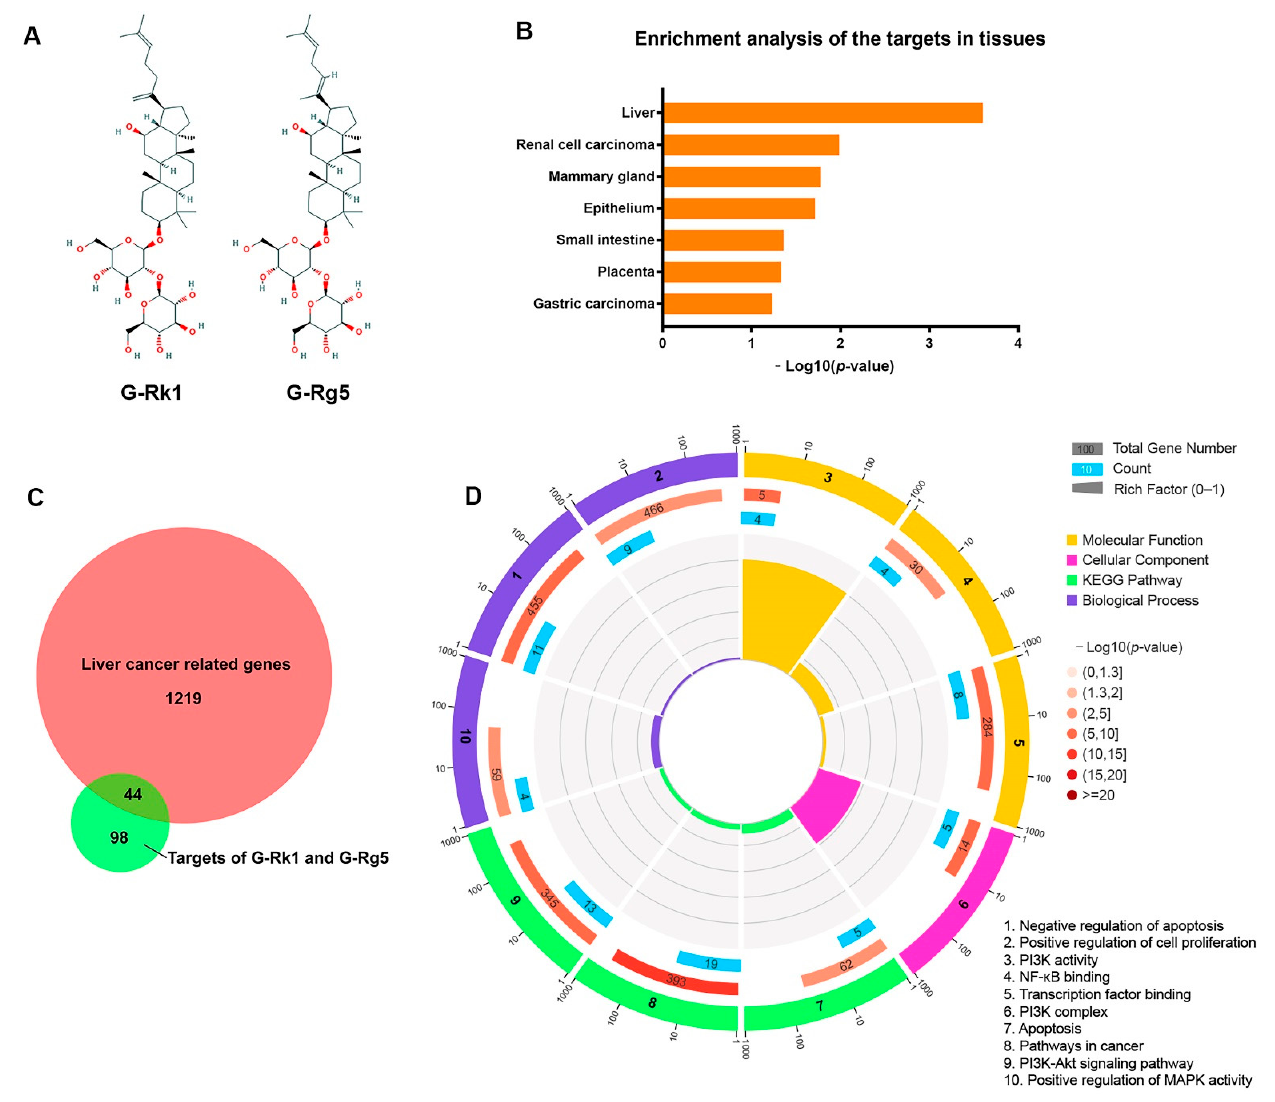
Figure 1. G-Rk1 and G-Rg5 targeting hepatocellular carcinoma related genes with an anti-cancer effect. ( A ) Chemical structures of G-Rk1 and G-Rg5. ( B ) Enrichment analysis of the potential target genes of G-Rk1 and G-Rg5 in human tissues. ( C ) The Venn diagram showed the crosstalk between hepatocellular carcinoma related genes and targets of two ginsenosides. The red part indicates hepatocellular carcinoma related genes, and the green part indicates targets of G-Rk1 and G-Rg5. ( D ) Gene Ontology (GO) and KEGG pathway enrichment analysis of the overlapped genes.